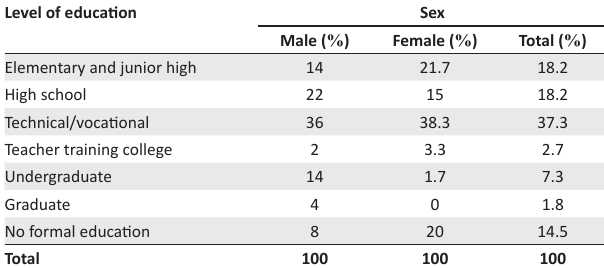
TABLE 3: Level of education by sex ( N = 110 Females 60 and males